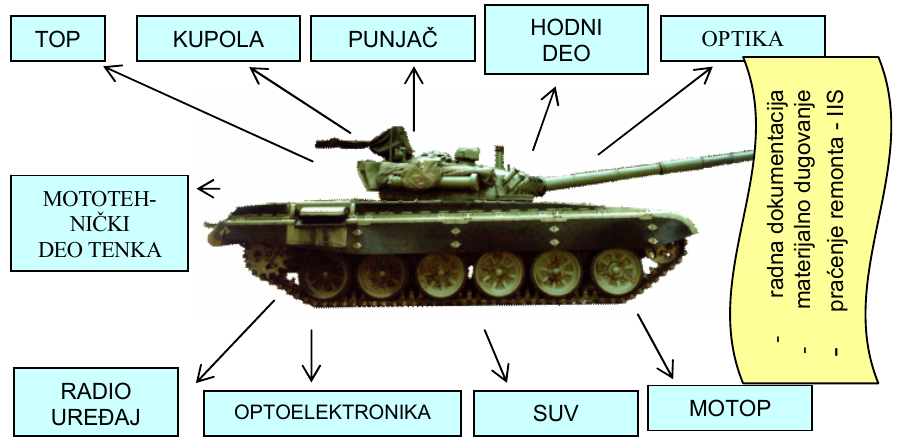
Figure 3 – Subsystems in a Complex technical system overhauling